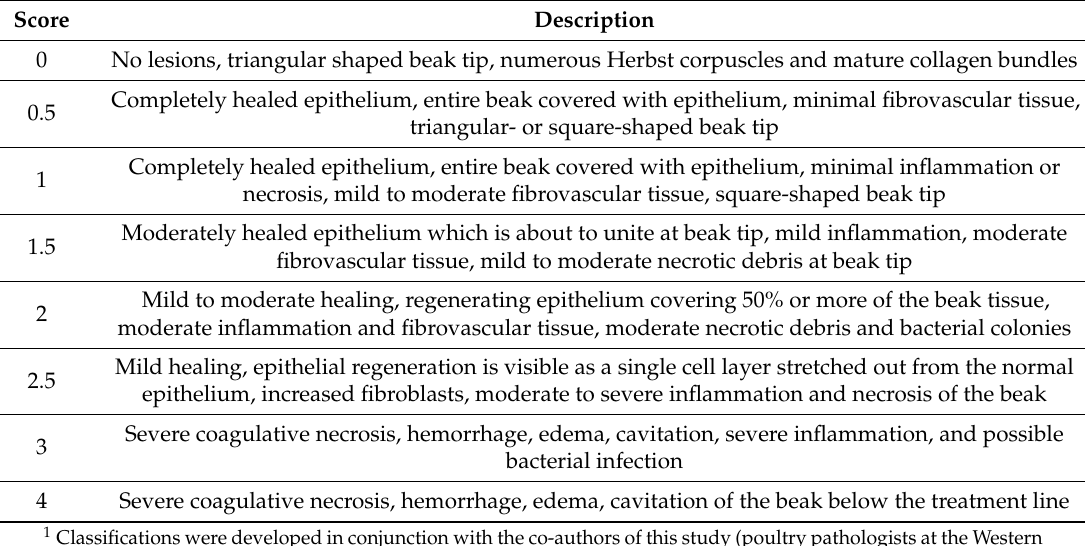
Table 2. Beak lesion classifications 1